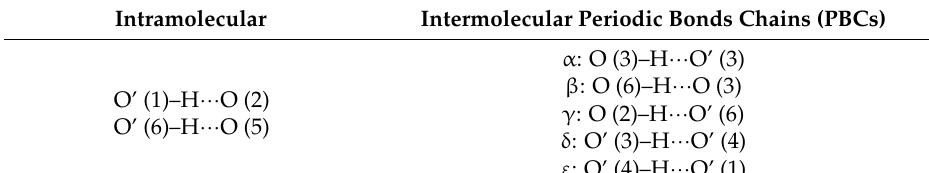
Table 2. Hydrogen bonds of sucrose separated from the methanol extract of A. gigas using ionic liquids.